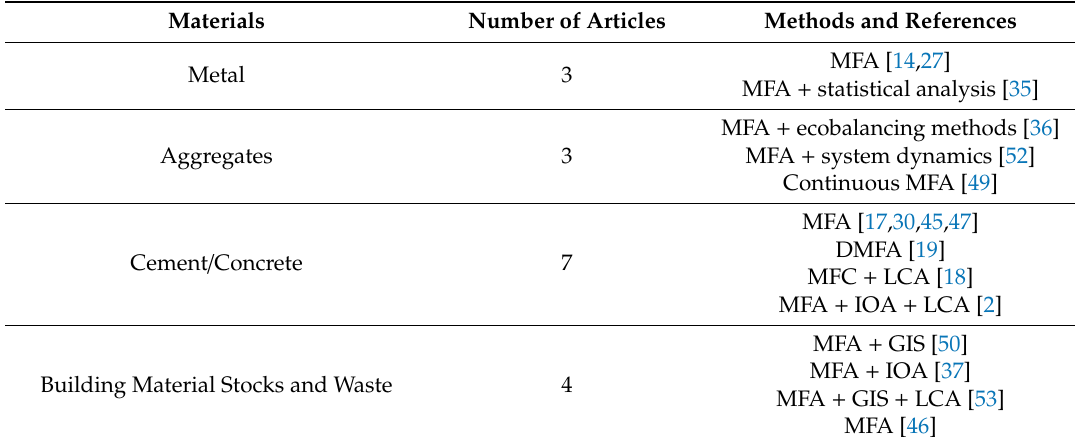
Table 5. Statistics regarding special materials and research